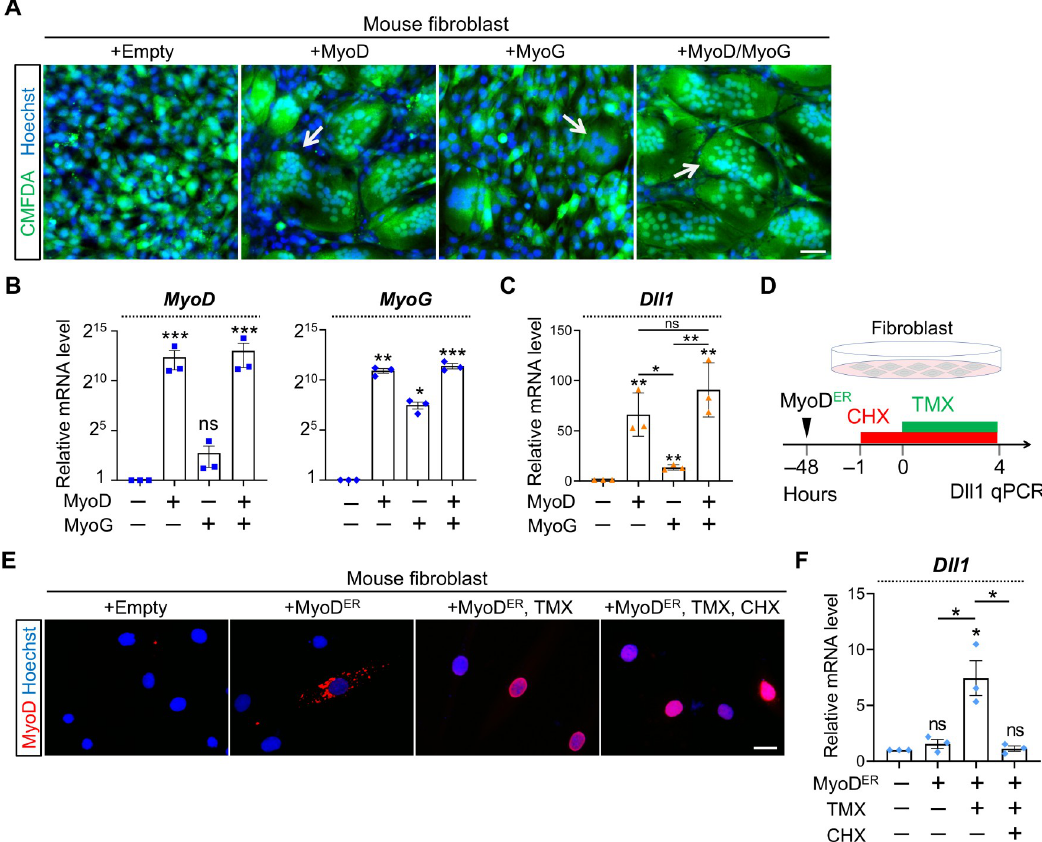
Fig 8. Sufficiency test of Dll1 inductions by MyoD in fibroblasts. ( A ) Fluorescence images of cell cytosol dye CMFDA (green) to highlight fibroblast syncytia induced by MyoD or MyoG. Scale bar, 100 μ m. ( B , C ) qPCR results of MyoD , MyoG (B), and Dll1 in mouse fibroblasts with forced expression of MyoD, MyoG or both. n = 3. ( D ) Schematic of experimental design to test the sufficiency of MyoD transcriptional activity in activating Dll1 expression in fibroblasts. ( E ) MyoD immunostaining of fibroblasts. TMX: tamoxifen. CHX: cycloheximide. Scale bar, 25 μ m. ( F ) qPCR results of Dll1 expression in fibroblasts after treatment illustrated in D. Note that induction of Dll1 expression by MyoD was abolished upon CHX treatment (5 hours). n = 3. Data are means ± SEM. � P < 0.05, �� P < 0.01, ��� P < 0.001. ns, not significant.